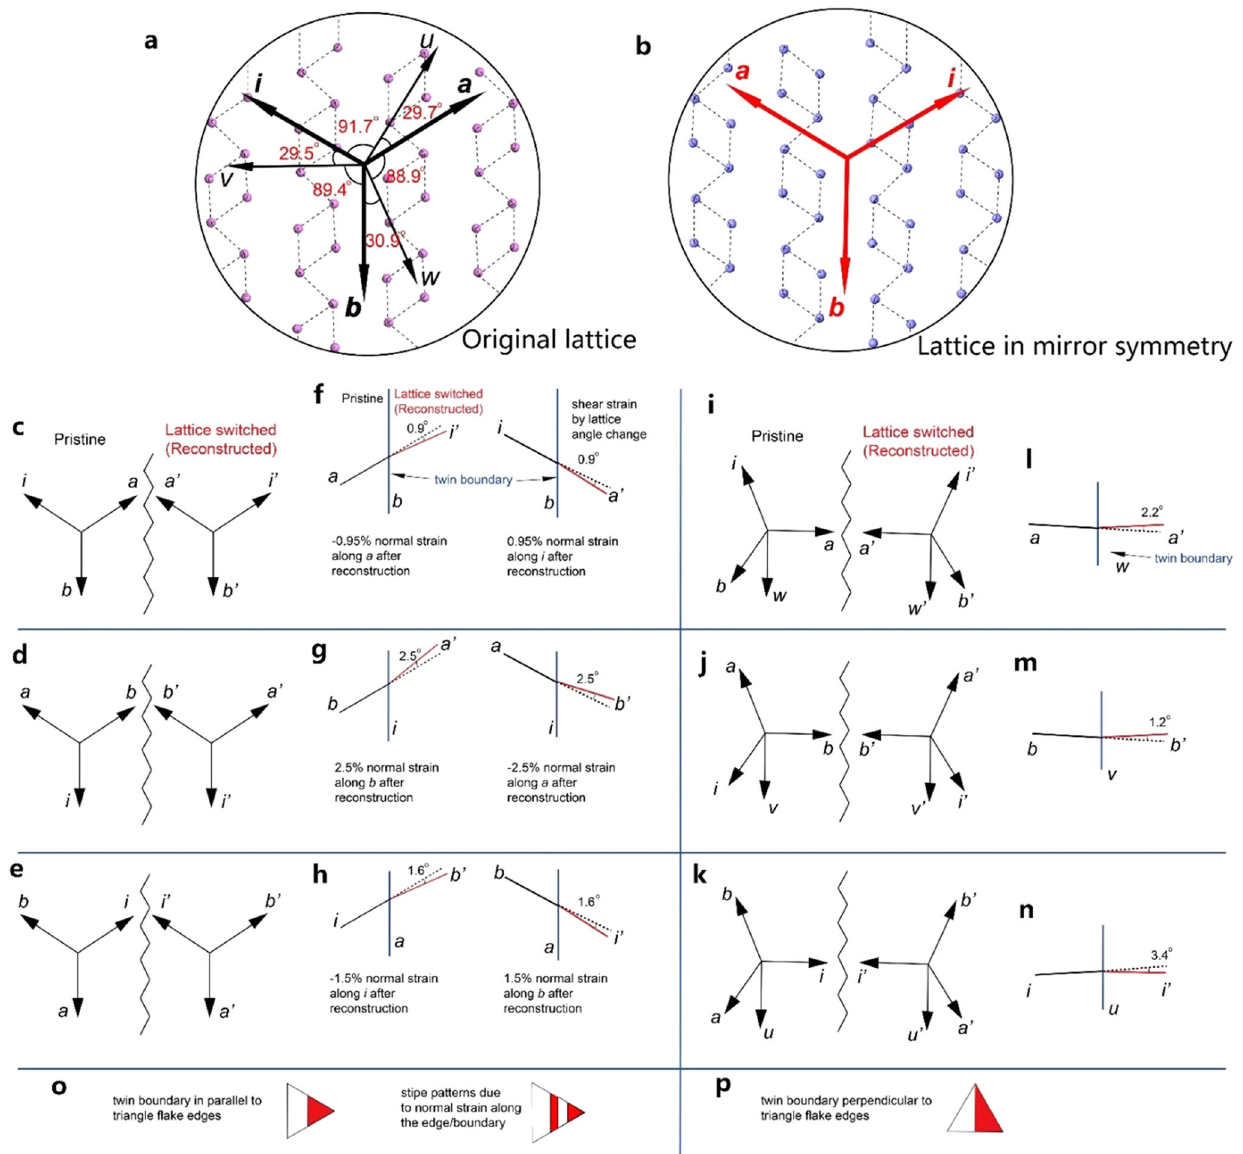
Fig. 6 The structural and strain analysis of twin structures by lattice reconstructions in 1L-ReS 2 . a The original (pristine) lattice relaxed by DFT calculations. Speci fi c vectors are de fi ned for low-index crystal orientations (<100> and <110> directions), and only Re atoms shown. b The lattice in mirror symmetry to a . Lattice in b can be considered as after reconstruction from a . c – e , i – k Scheme of the twinning domain boundaries (zigzag lines) along different low-index orientations. Lattice orientations for two opposite sides of twin boundaries are shown by arrows. f – h , l – n The shear angle of labeled crystal directions and the normal strain (only f – h , normal strain for l – n is zero) for reconstructed lattices compared to pristine lattices, corresponding to the six types of twin boundaries above ( c – e , i – k ), respectively. o , p The domain types resulted from corresponding lattice reconstructions. Panel o corresponds to c – e type twin boundaries, while panel p corresponds to i – k type twin